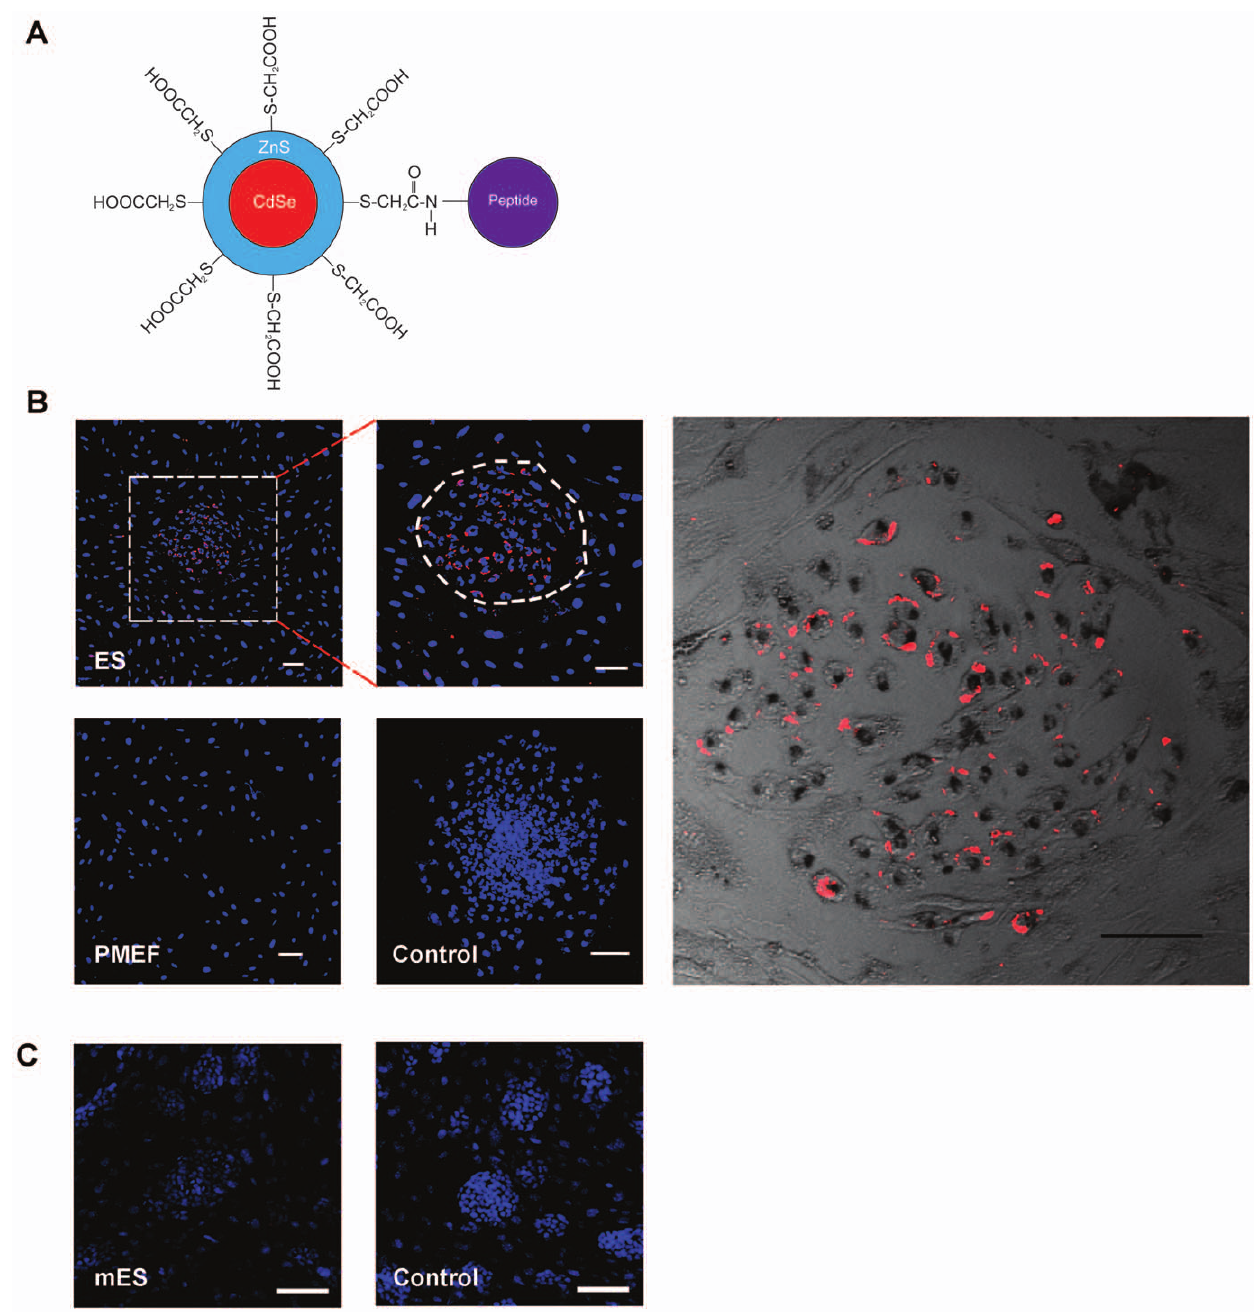
Figure 4. Targeting of ES cells by peptide-conjugated quantum dots. (A) Scheme of the peptide-conjugated quantum dots. (B) Bright-field and fluorescence microscopy of APWHLSSQYSRT peptide-conjugated quantum dots targeting ES cells. Dashed circle shows an ES cell colony. The fluorescence signal of peptide-conjugated quantum dots is shown in red and cell nuclei are shown in blue (Hoechest 33258). PMEF cells and quantum dots without conjugation of peptides were set as the controls. Scale bar, 100 m m. (C) Fluorescence microscopy of APWHLSSQYSRT peptide- conjugated quantum dots with mouse ES (mES) cells. The binding of APWHLSSQYSRT peptide-conjugated quantum dots to mES cells were undetectable. Free quantum dots without conjugation of peptides were set as the control. Scale bar, 100 m m.